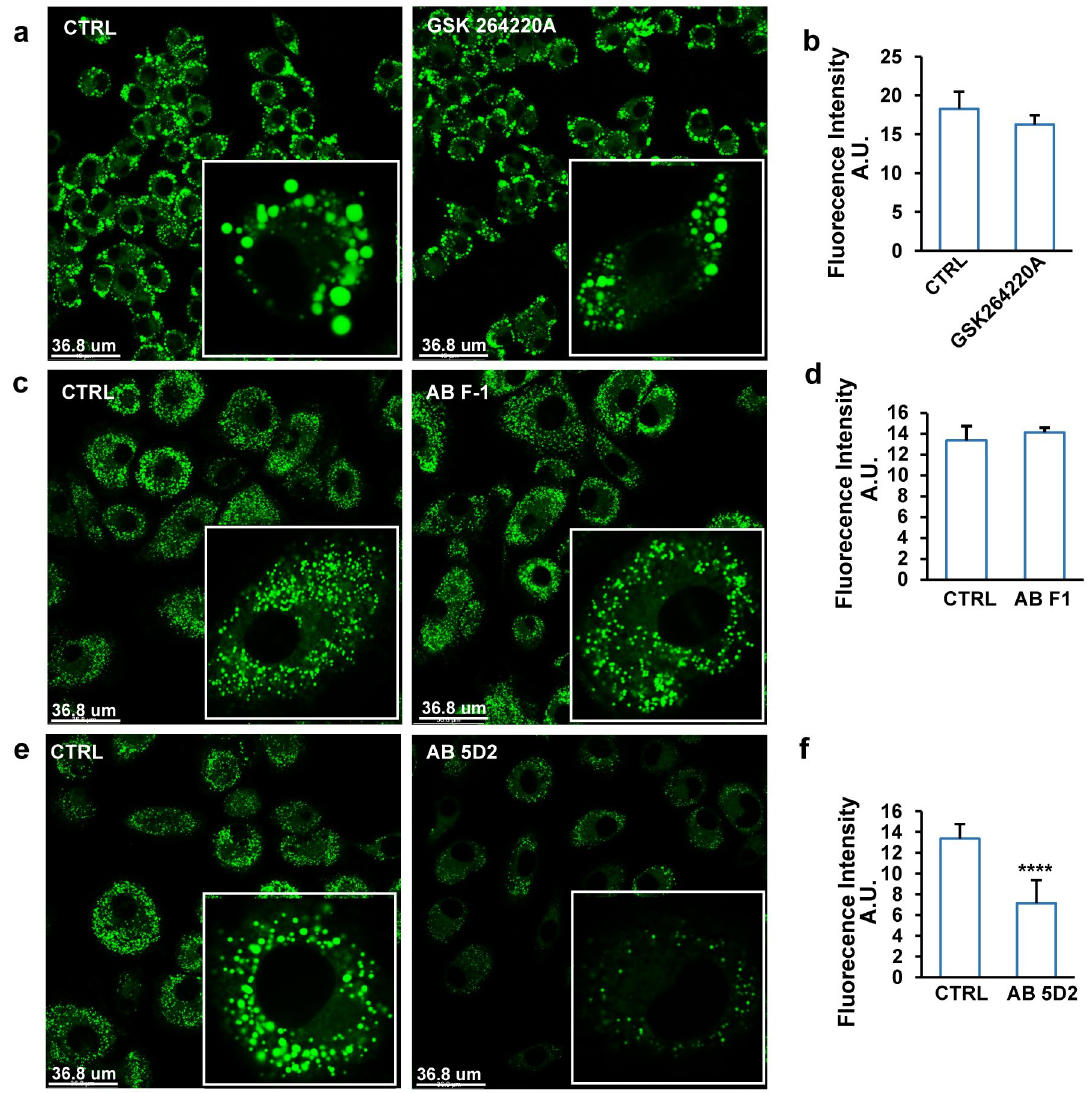
Fig 3. The C-terminal portion of LPL mediates uptake of VLDL-sized emulsion particles in cultured macrophages. (a) BODIPY 493/503 staining of RAW 264.7 macrophages treated with 1 mM VLDL-sized emulsion particles for 6 hours in the presence or absence of 0.2 μ M of the catalytic LPL inhibitor GSK264220 ( n = 6). (b) Mean fluorescence intensity quantified by Image J ( n = 4). (c) BODIPY 493/503 staining of human primary macrophages treated with 0.5 mM VLDL-sized emulsion particles for 6 hours in the presence or absence of antibody F1 targeting the N-terminal portion of LPL (2 μ g/ml) ( n = 6). (d) Mean fluorescence intensity quantified by Image J ( n � 4). (e) BODIPY 493/503 staining of human primary macrophages treated with 0.5 mM VLDL-sized emulsion particles for 6 hours in the presence or absence of antibody 5D2 targeting the C-terminal of LPL (2 μ g/ml) ( n = 6). (f) Mean fluorescence intensity quantified by Image J ( n � 4). The bar graphs were plotted as mean ± SD. Asterisk indicates significantly different from control according to Student t test. ���� p < 0.0001. (The raw data of bar graphs can be found in “S1 Raw Data”.) LPL, lipoprotein lipase; VLDL, very low- density lipoprotein. cholesterol from lysosomes to the ER [19], we hypothesized that STARD3 may have a similar role in the intracellular trafficking of fatty acids derived from VLDL-sized emulsion particles. In line with this hypothesis, silencing of STARD3 (Fig 8B) in human macrophages treated with VLDL-sized emulsion particles increased lipid accumulation in lysosomes and reduced lipid content in the ER (Figs 8C, 8D, S4, and S5). Unlike silencing of NPC1, silencing of